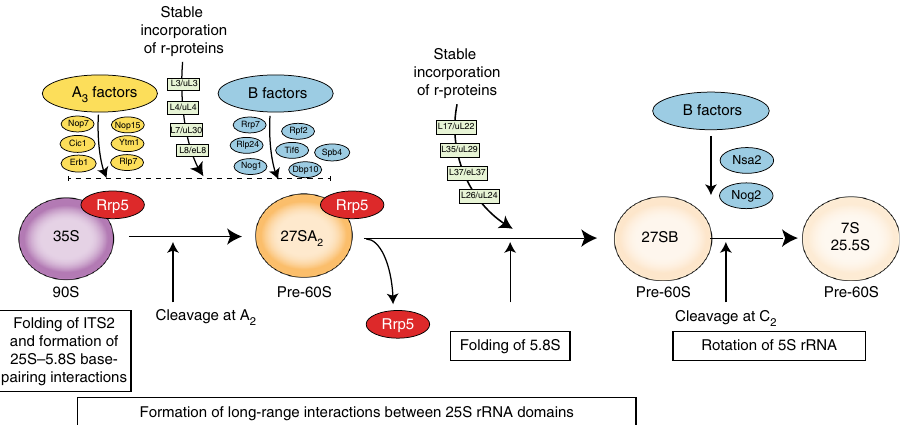
Fig. 7 Model of rRNA structural changes and pre-60S remodeling steps that take place during the nucleolar stages of 60S synthesis. ITS2 forms a highly compact structure in the nascent transcript. We predict that base-pairing interactions between 25S and 5.8S have already been formed co- transcriptionally. Major rRNA restructuring events occur in pre-ribosomal complexes during the conversion of 27SA 2 pre-rRNA to 27SB pre-rRNA. These include the compaction of the 5.8S region and formation of long-range interactions in the 25S sequence. All these changes occur after Rrp5 dissociates and in the presence of A 3 and early B factors. After C 2 cleavage, the 5S rRNA rotates to adopt its fi nal structure